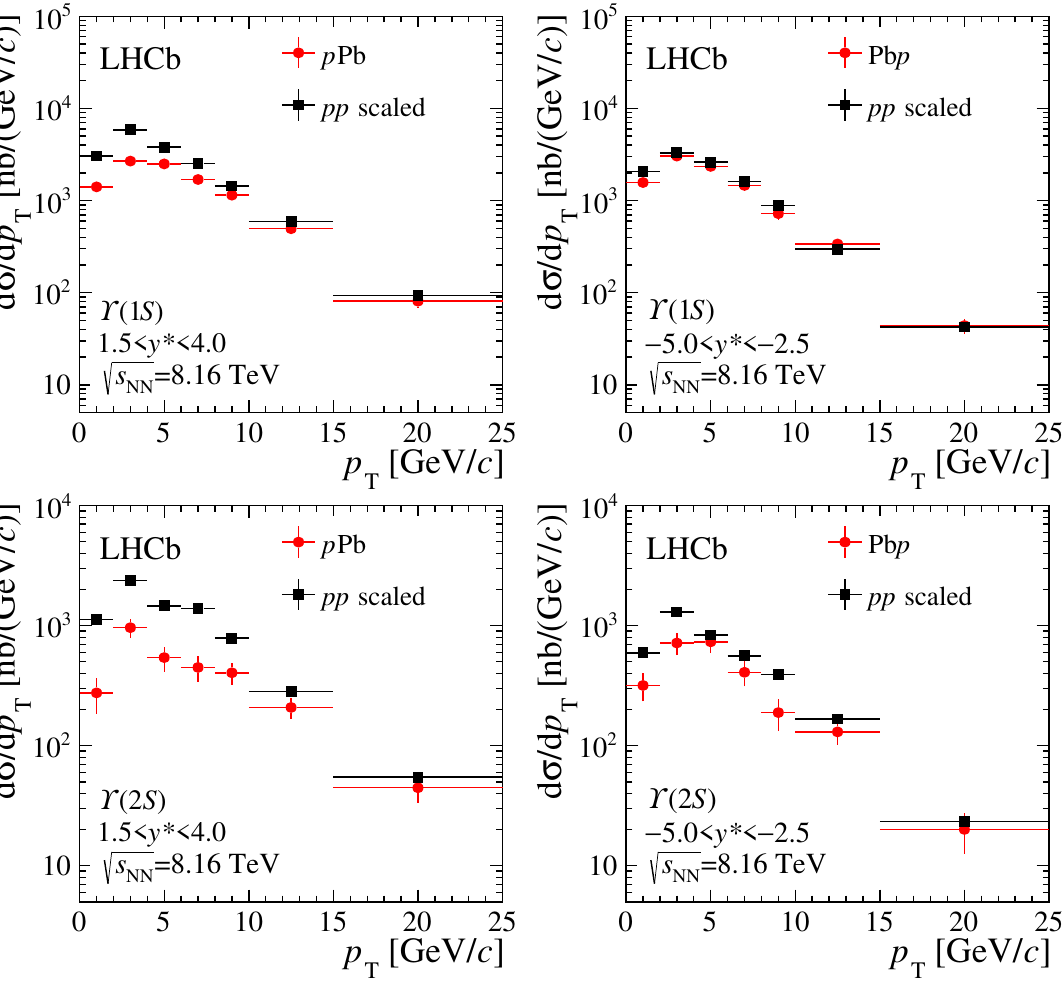
Figure 5 . Cross-section of (top) (cid:7) (1 S ) and (bottom) (cid:7) (2 S ) production as a function of p T inte- grated over y (cid:3) for the (left) forward and (right) backward samples compared to the cross-section p measured in pp , interpolated to s = 8 : 16 NN